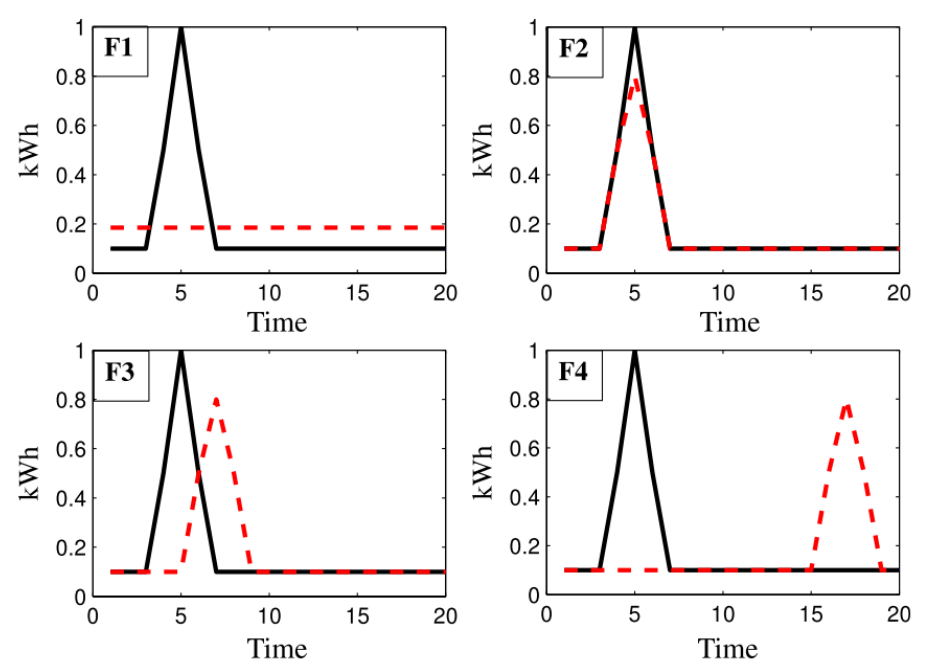
Figure 1. Four different predictions F1, F2, F3, and F4 (dotted lines) compared to the actual value (solid lines). Source: Reprinted with permission from